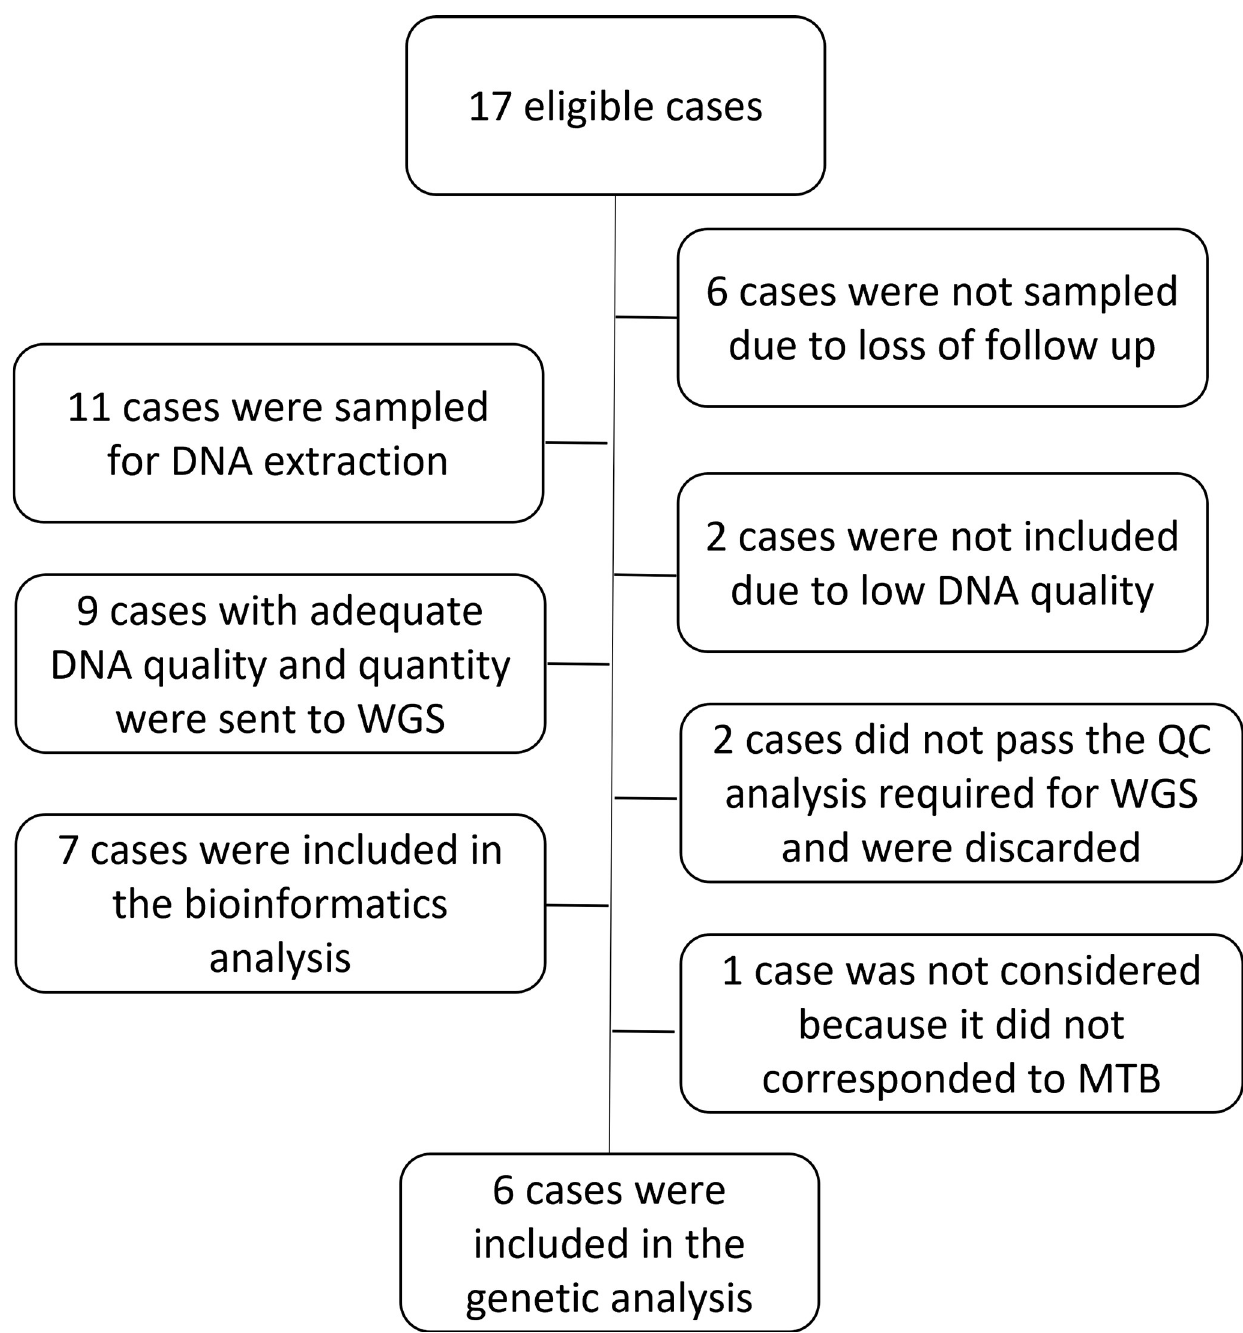
Fig 1. Flow diagram for patient